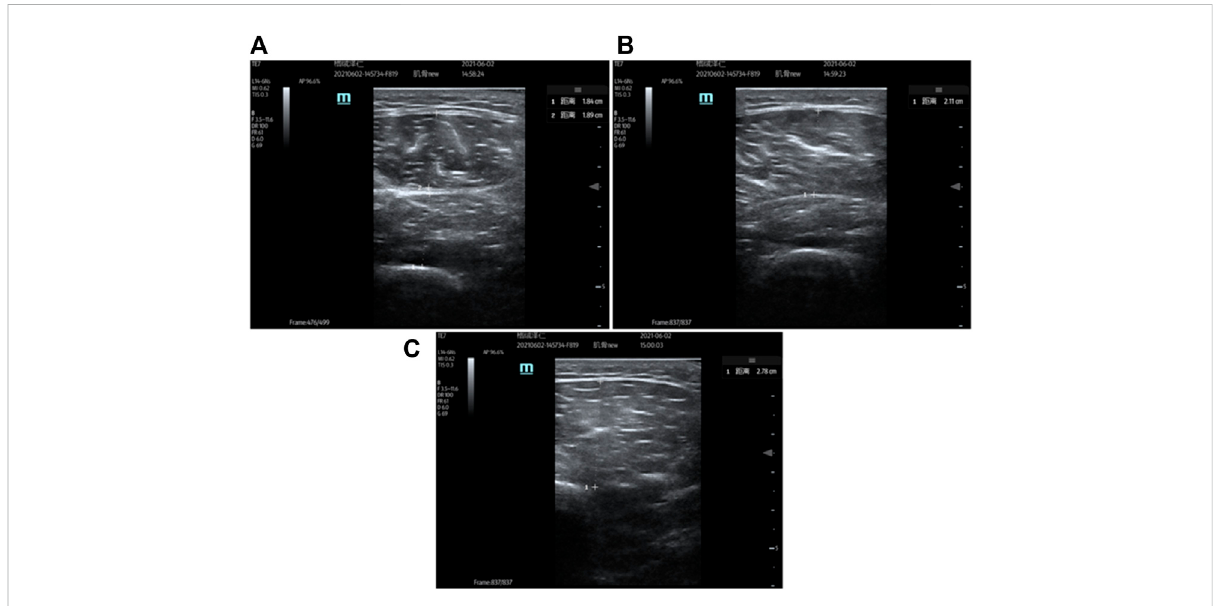
FIGURE 3 Ultrasound measurement of quadriceps thickness [ (A) : ultrasound measurement of the rectus femoris and vastus intermedius; (B) ultrasound measurement of the vastus lateralis; (C) ultrasound measurement of the vastus